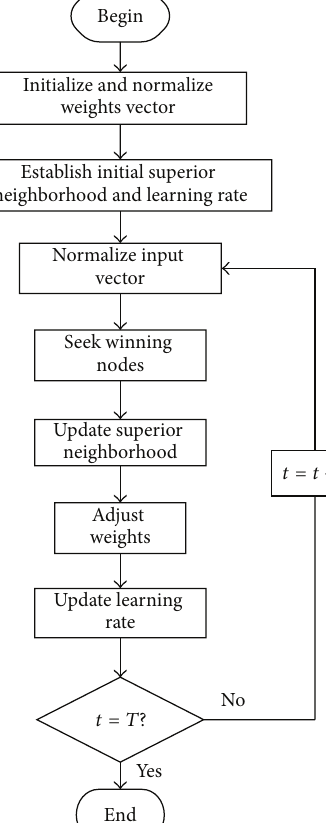
Figure 7: Flowchart of SOM